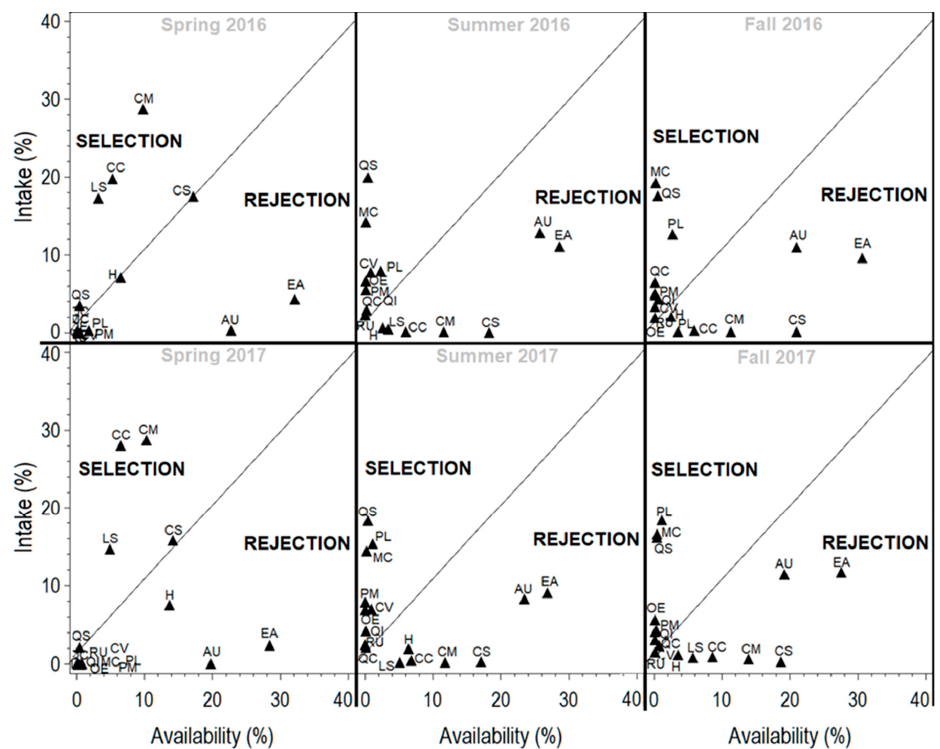
Figure 2. Seasonal selection vs. rejection of plant species consumed by goats browsing a Southern Mediterranean forest rangeland during 2016 and 2017. AU: Arbutus unedo; CC: Cistus crispus; CM: Cistus monspeliensis; CS: Cistus salviifolius; CV: Calicotome villosa; EA: Erica arborea; H: Herbaceous ; LS: Lavandula stoechas; MC: Myrtus communis; OE: Olea europaea; PL: Pistacia lentiscus; PM: Phillyrea media; QC: Quercus canariensis ; QI: Quercus ilex; QS: Quercus suber; RU: Rubus ulmifolius.